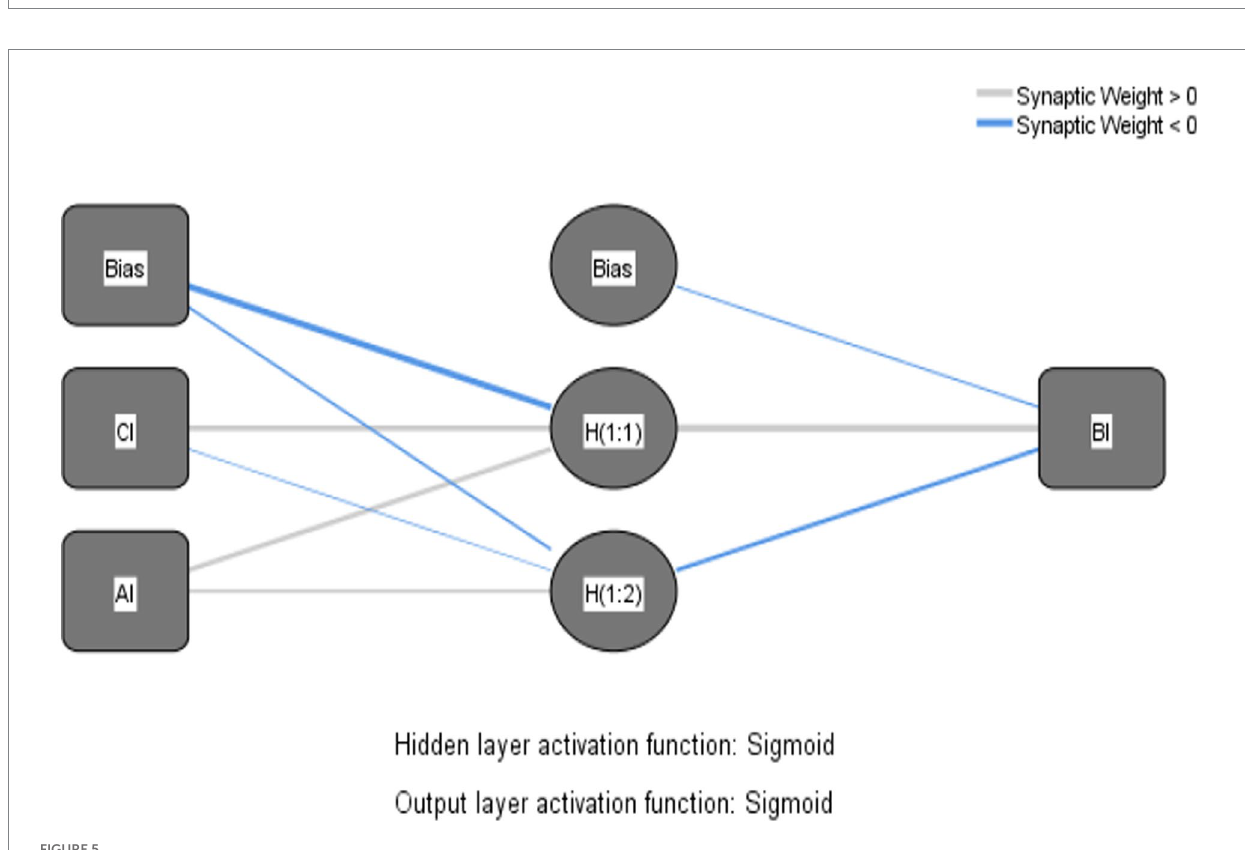
FIGURE 5 Neural network model – felt urge to buy impulsively.